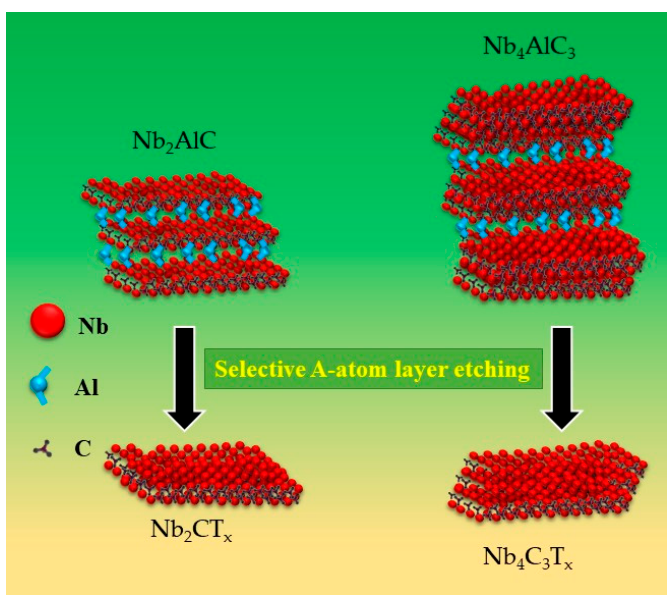
Figure 3. Schematic illustration of HF synthesis of MXene from their MAX precursor and its effects, as well as various forms of Nb 2 CT x and Nb 4 C 3 T x MXenes.